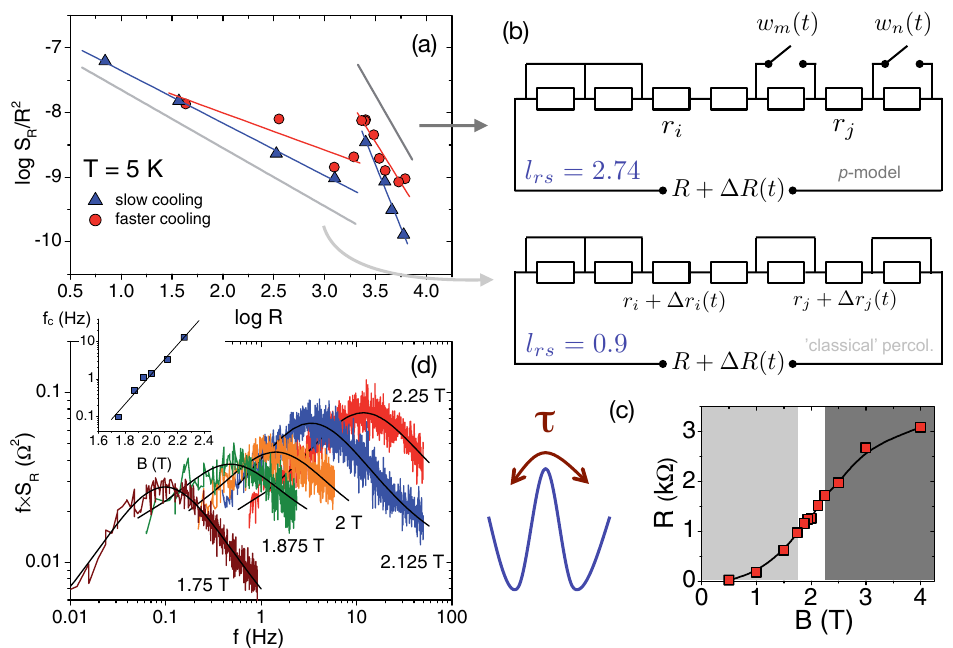
FIG. 4 (color online). (a) Scaling of the normalized noise Figure 6. Percolation models in superconductors. ( a ) scaling of the normalized noise S R / R 2 ∝ R l rs S R =R 2 versus the resistance R , for the data in Fig. 3. (b) PSD of κ -Cl ∗ in a representation log S R / R 2 vs. log R , where the slope reveals the power-law exponent l rs , in the vicinity of the maximum noise level as f S R vs f . Lines * for data taken at T = 5K and different magnetic fields up to 4T as an implicite tuning are fits to Eq. (1) plus a 1 =f background term. The inset shows the shift of the peak frequency f p with applied magnetic field B . states. Lines in Fig. 4(b) are fits to a 1 =f background plus Eq. (1) showing that an individual fluctuator dominates the noise. The inset of Fig. 4 shows a clear shift of the peak